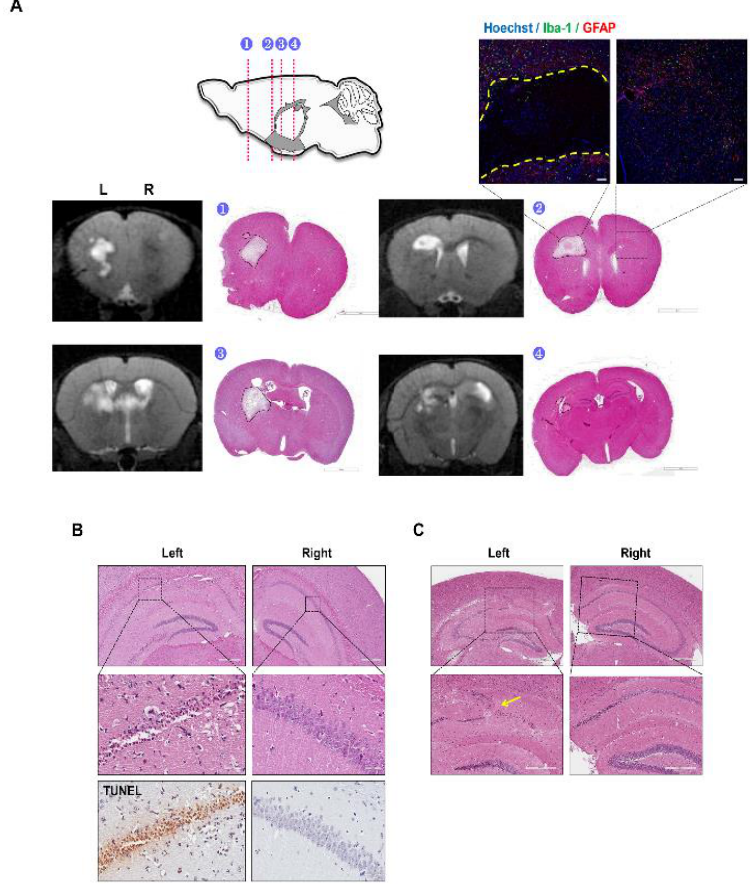
Figure 2. Pathological features of C57VCI mice. Infarcts observed from the T2 weighted MR images were confirmed through histological staining (H&E). (1) forceps minor, (2) external capsule of the corpus callosum, (3) internal capsule and caudate putamen, and (4) hippocampal fimbria. ( A ) Immunohistochemical staining was performed to observe expressions of microglia (Iba-1) and astrocytes (GFAP) in the contralesional (upper inset: right) and ipsilesional sides (upper inset: left). L indicates left and R indicates the right hemisphere of the mouse brain. Scale bar = 2 mm (H&E), 10 µ m (Confocal image, upper right inset). ( B ) Loss of neuronal cells in the unilateral (left side in this case) hippocampus was observed by H&E and TUNEL stains. ( C ) Solid yellow arrow indicates abnormal folding of the hippocampal structure in the left hippocampus. Scale bars = ( B ) From top to bottom: 400, 50, and 50 µ m, ( C ) From top to bottom: 600 and 300 µ